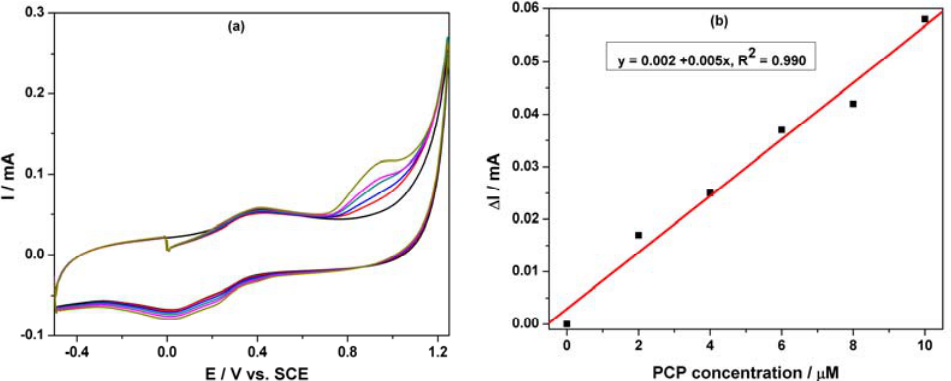
Figure 4. ( a ) Cyclic voltammograms of the MWCNT-EP composite electrode recorded at a potential scan rate of 0.05 Vs − 1 and a potential range between − 0.5 and +1.25 V/SCE in 0.1 M Na SO supporting electrolyte (curve 1) and in the presence of different PCP 2 4 concentrations: (2) 2 µM; (3) 4 µM ; (4) 6 µM; (5) 8 µM; (6) 10 µM. ( b ) The calibration